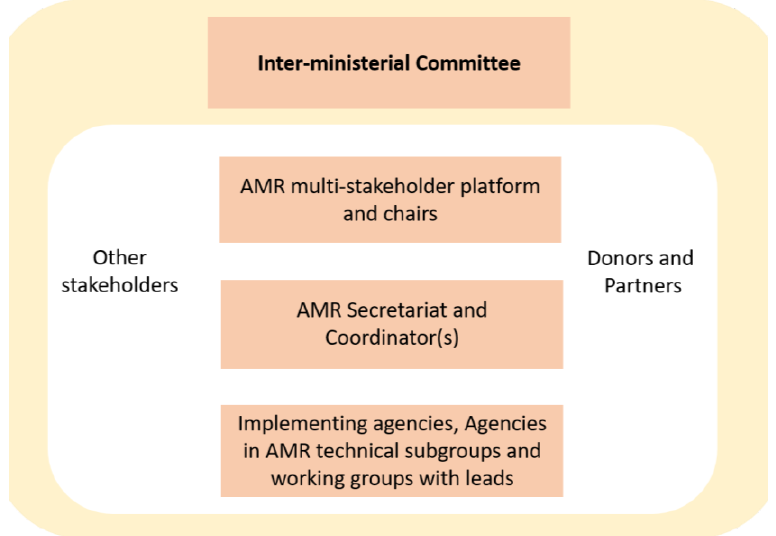
Figure 1. AMR Country Level Governance Framework. Source: Own design, based on Ghana National Action Plan, p. 7.